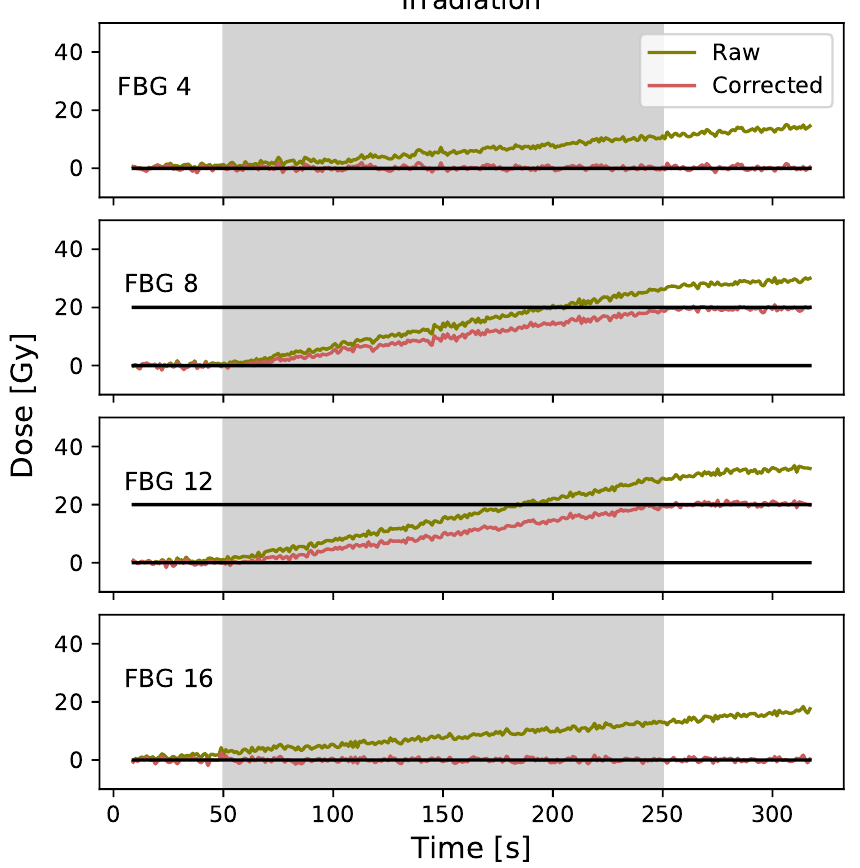
Figure 6. Raw and corrected data were obtained using the ITG technique. FBG #4 and #16 are located outside the irradiation field and FBG #8 and #12 are located inside the